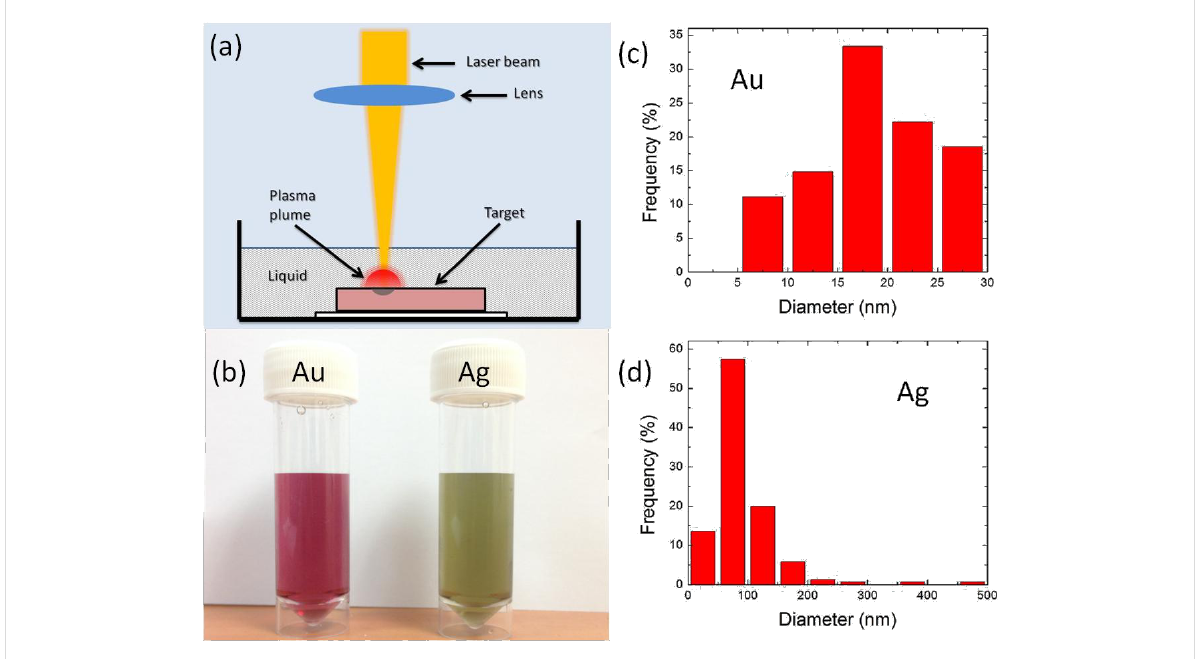
Figure 1: (a) Schematic of the LAL experimental setup. (b) Photograph of laser-generated gold and silver nanoparticle dispersions by the LAL tech- nique. Size distributions of (c) gold and (d) silver nanoparticles estimated from SEM